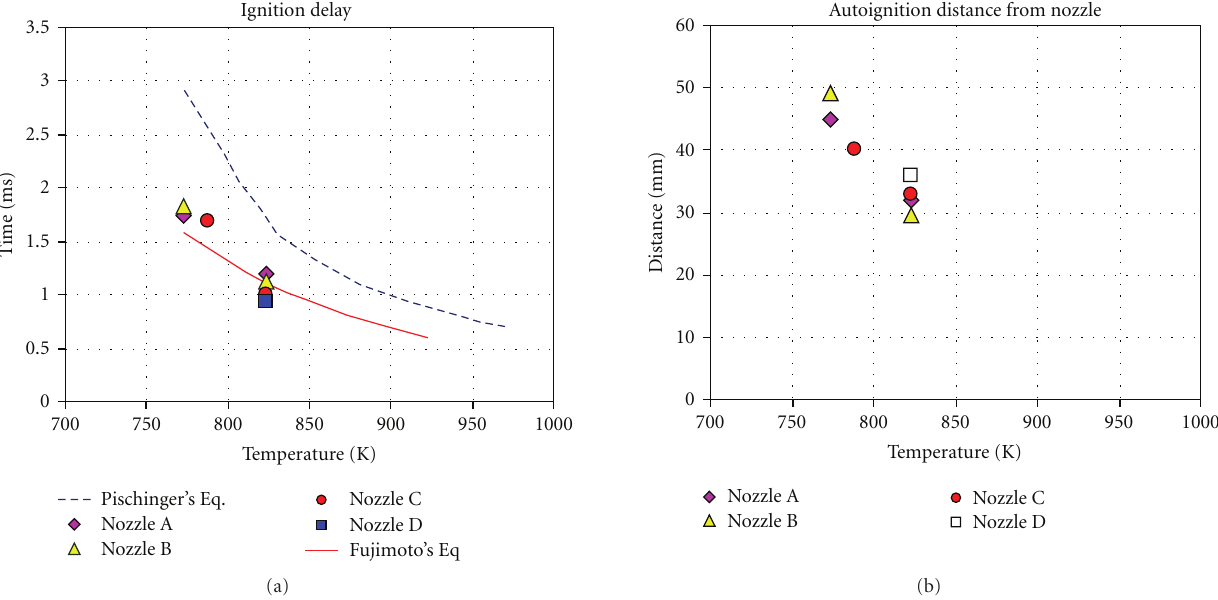
Figure 20: Ignition delay time and autoignition distance from nozzle tip for di ff erent type of nozzles (3.5 MPa ambient pressure, 50 MPa injection pressure, 1.5 ms injection